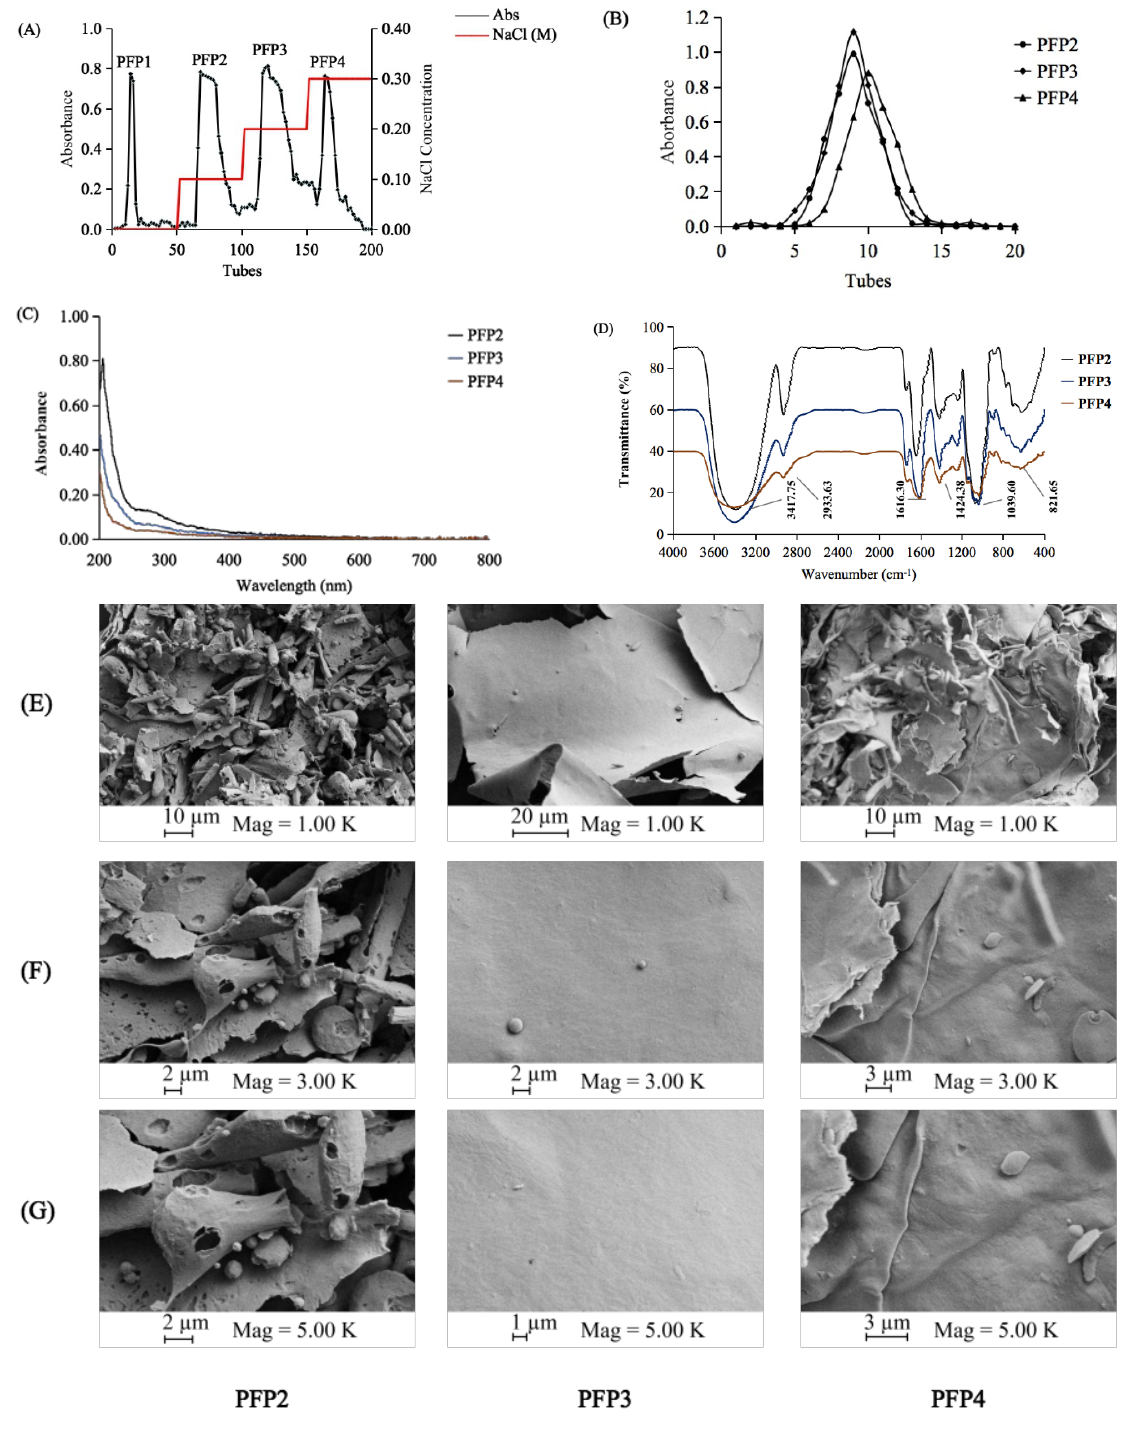
Figure 1. Separation and spectra of PFP2, PFP3, and PFP4. DEAE-cellulose elution curve ( A ); Sephadex G-100 elution curve ( B ); The UV–Vis spectra ( C ); IR spectra ( D ); and SEM images ( E : × 1k; F : × 3k; G : ×